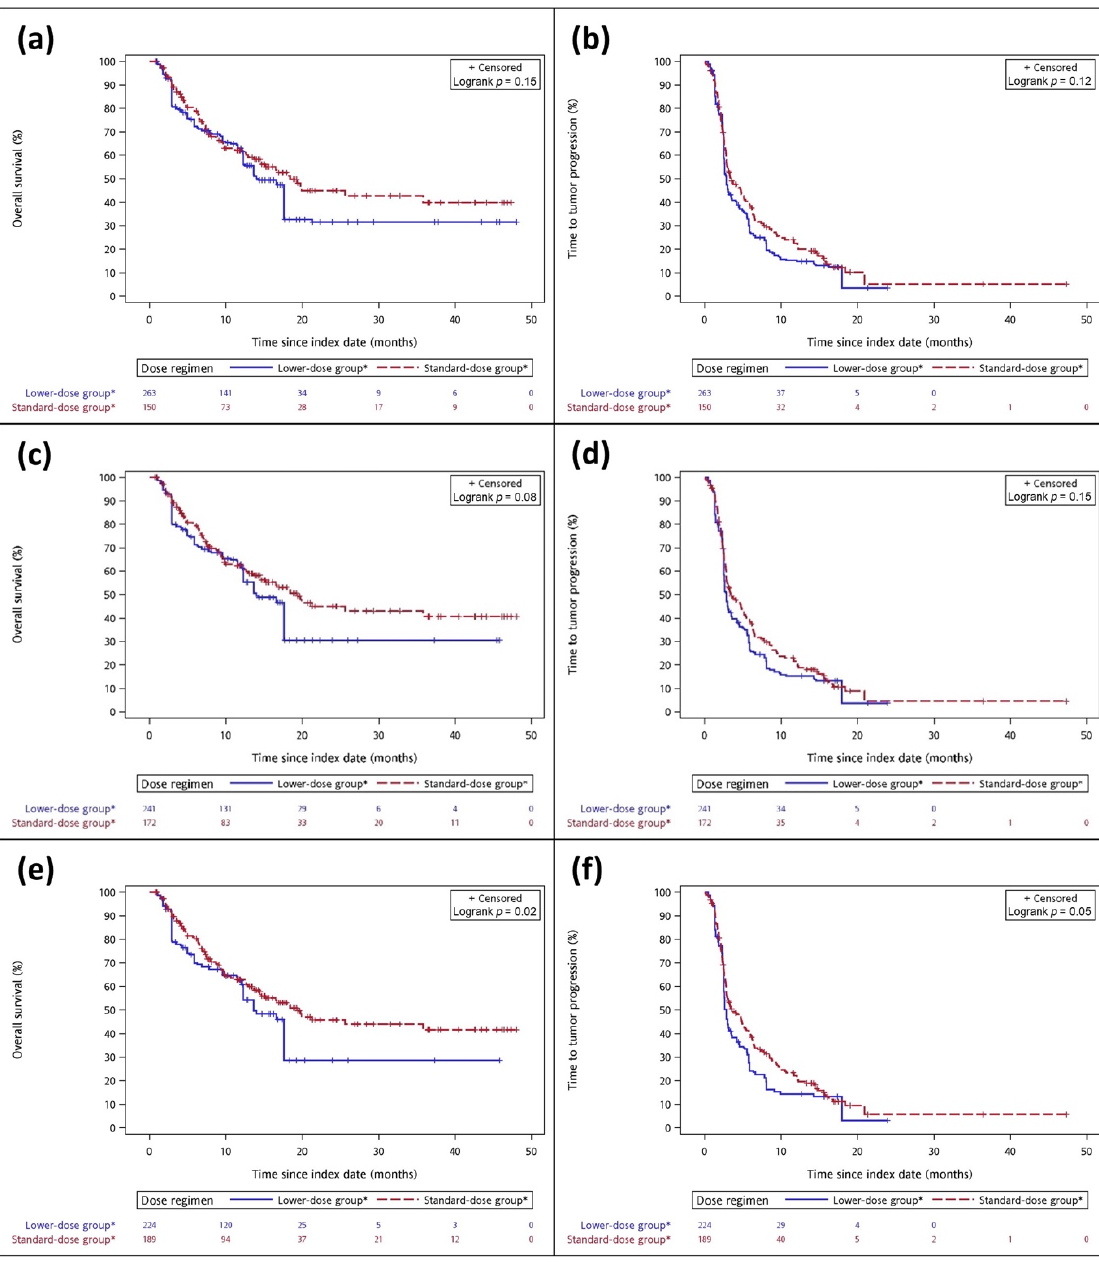
Figure 2. Kaplan–Meier curve of OS and TTP between standard-dose and low-dose groups after IPTW adjustment. ( a ) OS between standard-dose group and lower-dose group; ( b ) TTP between standard-dose group and lower-dose group cohort; ( c ) OS between standard-dose group ( ≥ 1.9 mg/kg) and lower-dose group; ( d ) TTP between standard-dose group ( ≥ 1.9 mg/kg) and lower-dose group; ( e ) OS between standard-dose group ( ≥ 1.8 mg/kg) and lower-dose group; ( f ) TTP between standard-dose group ( ≥ 1.8 mg/kg) and lower-dose group. Note: * The patient number was adjusted by IPTW methods.